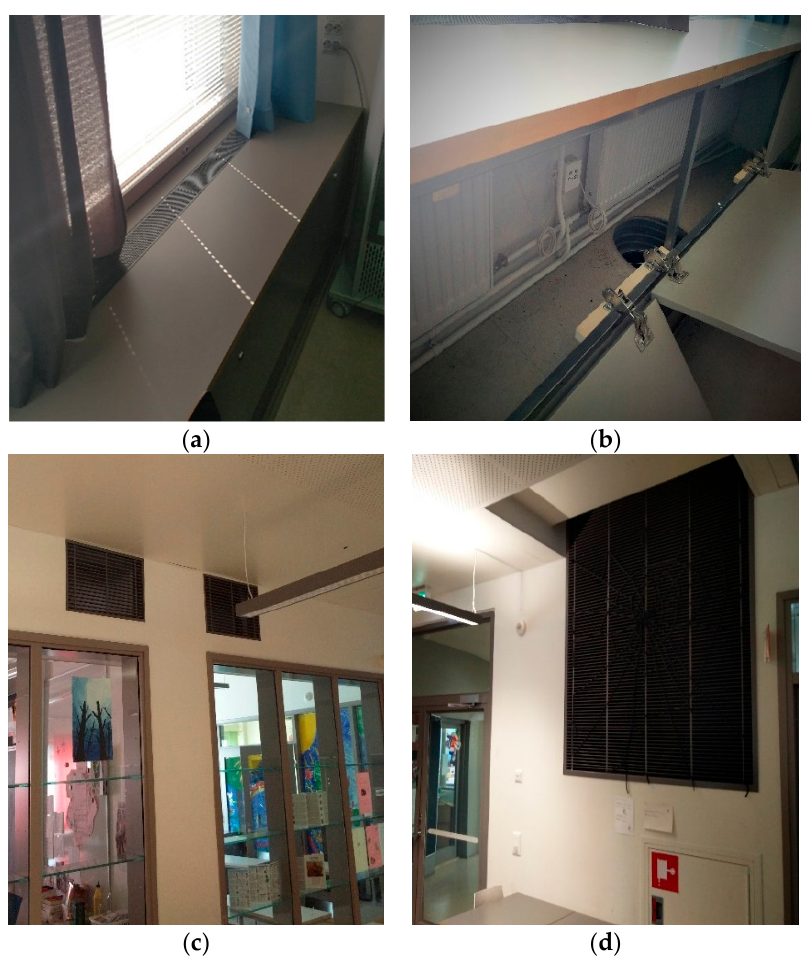
Figure 3. ( a , b ) Supply air grill and duct in the classrooms; ( c ) transfer air grilles in the partitions